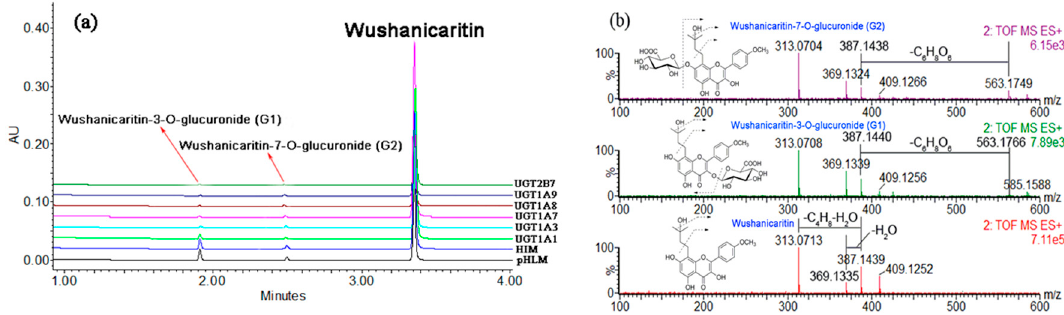
Figure 1. Ultra-high performance liquid chromatography analysis ( a ) and MS/MS spectrum ( b ) of wushanicaritin, wushanicaritin-3- O -glucuronide (G1) and wushanicaritin-7- O -glucuronide